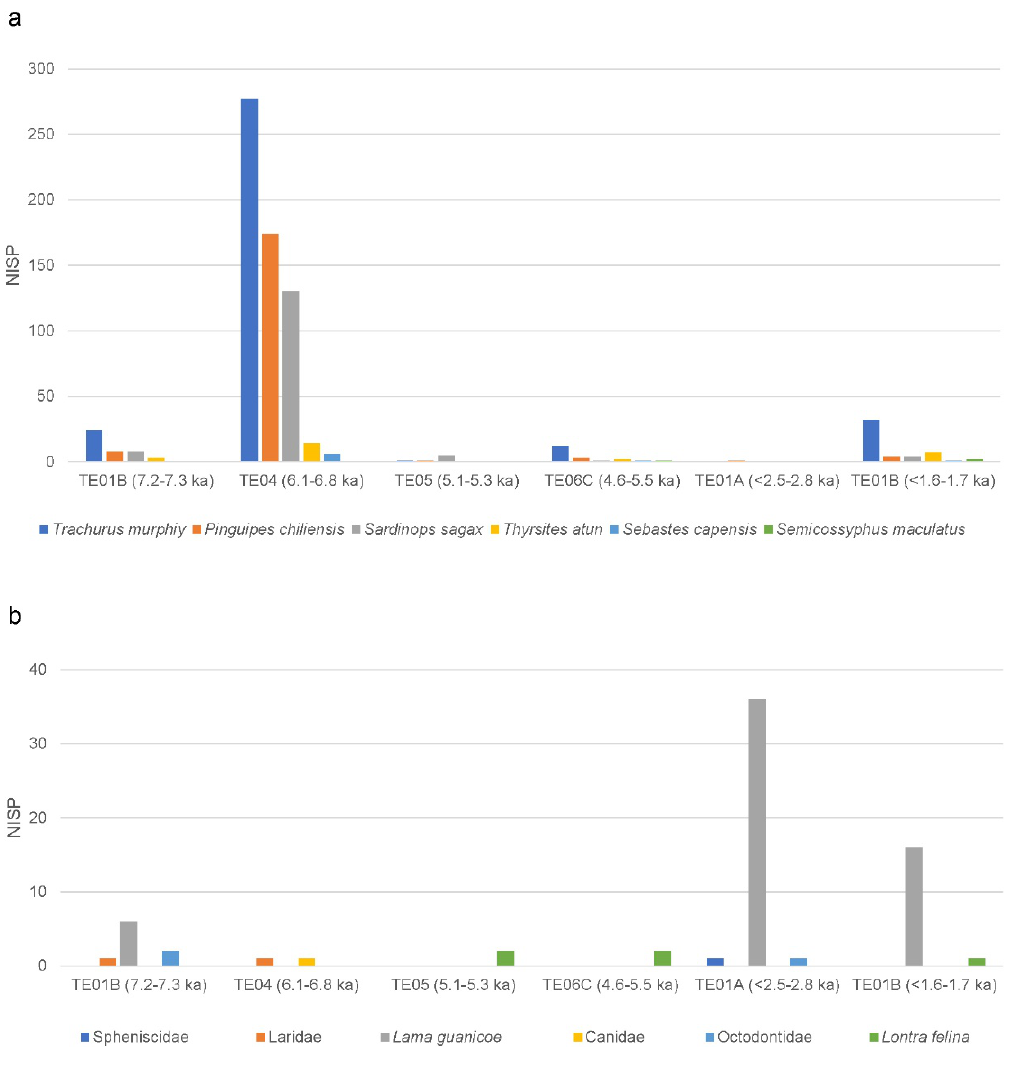
Figure 6. Animal bone assemblages of the studied sites: ( a ) ichthyoarchaeological assemblages identified to the species level (NISP); ( b ) tetrapod assemblages identified to the genus and species levels (NISP).